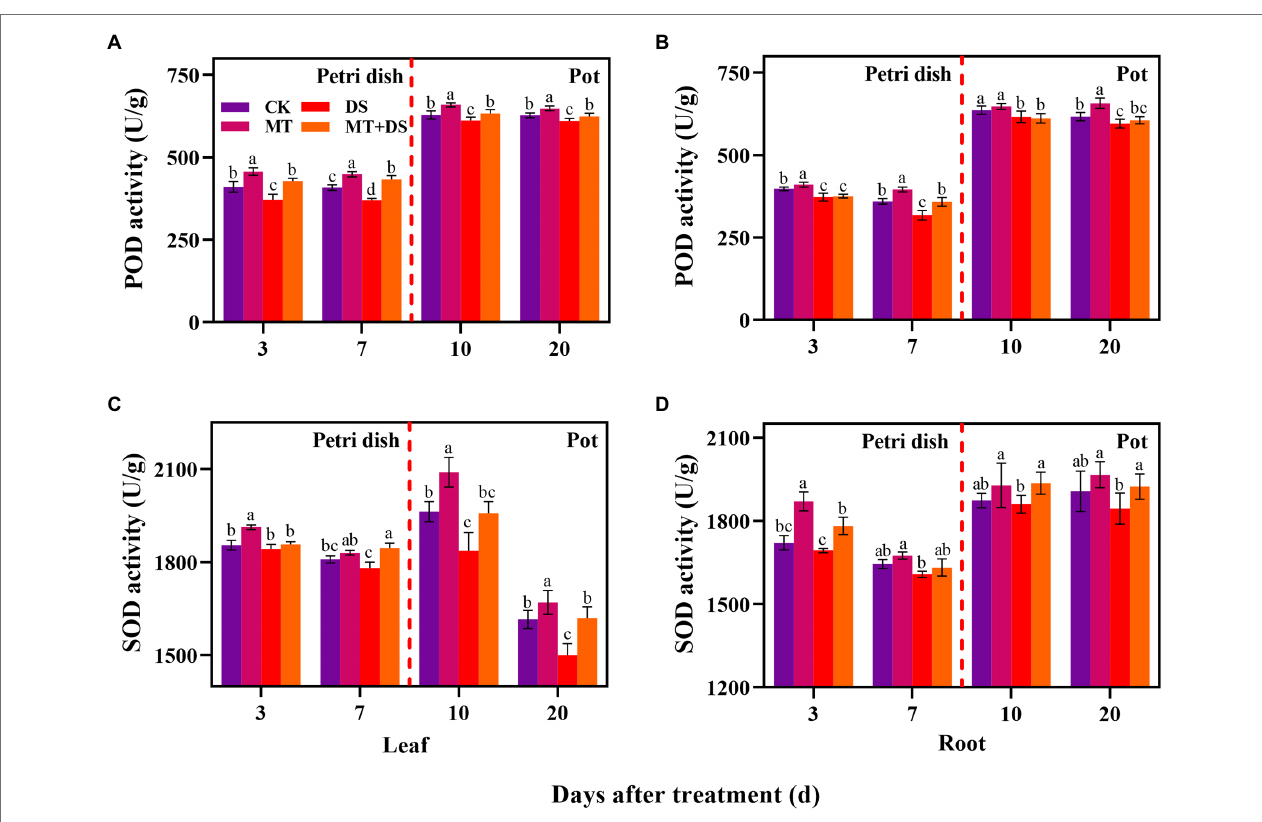
FIGURE 7 | In Petri dish, 20 μ M MT was used as the optimal priming treatment for triticale seeds priming (MT), 0 μ M MT as normal treatment (CK), 10% PEG as drought treatment (DS), and 20 μ M MT + 10% PEG treatment (MT+DS). In pot, 20 μ M MT was used as the optimal priming treatment for triticale seedlings, unprimed +70–75% relative water content as CK, primed +70–75% relative water content as MT, unprimed +40–45% relative water content as DS, and primed +40–45% relative water content as MT+DS. The contents of POD (A) and (B) , SOD (C) and (D) in leaves and roots of triticale seeds germinated in Petri dishes at 3 and 7 days and seedlings planted at 10 and 20 d. For each trait, bars with the same letter are not significantly different ( p < 0.05). Different lower letters indicate that there are significant differences in all concentration treatments ( p < 0.05). Data shown are the averages ± SE ( n = 6 in A and B; n = 3 for Petri dish in C,D , n = 6 for pot in C,D